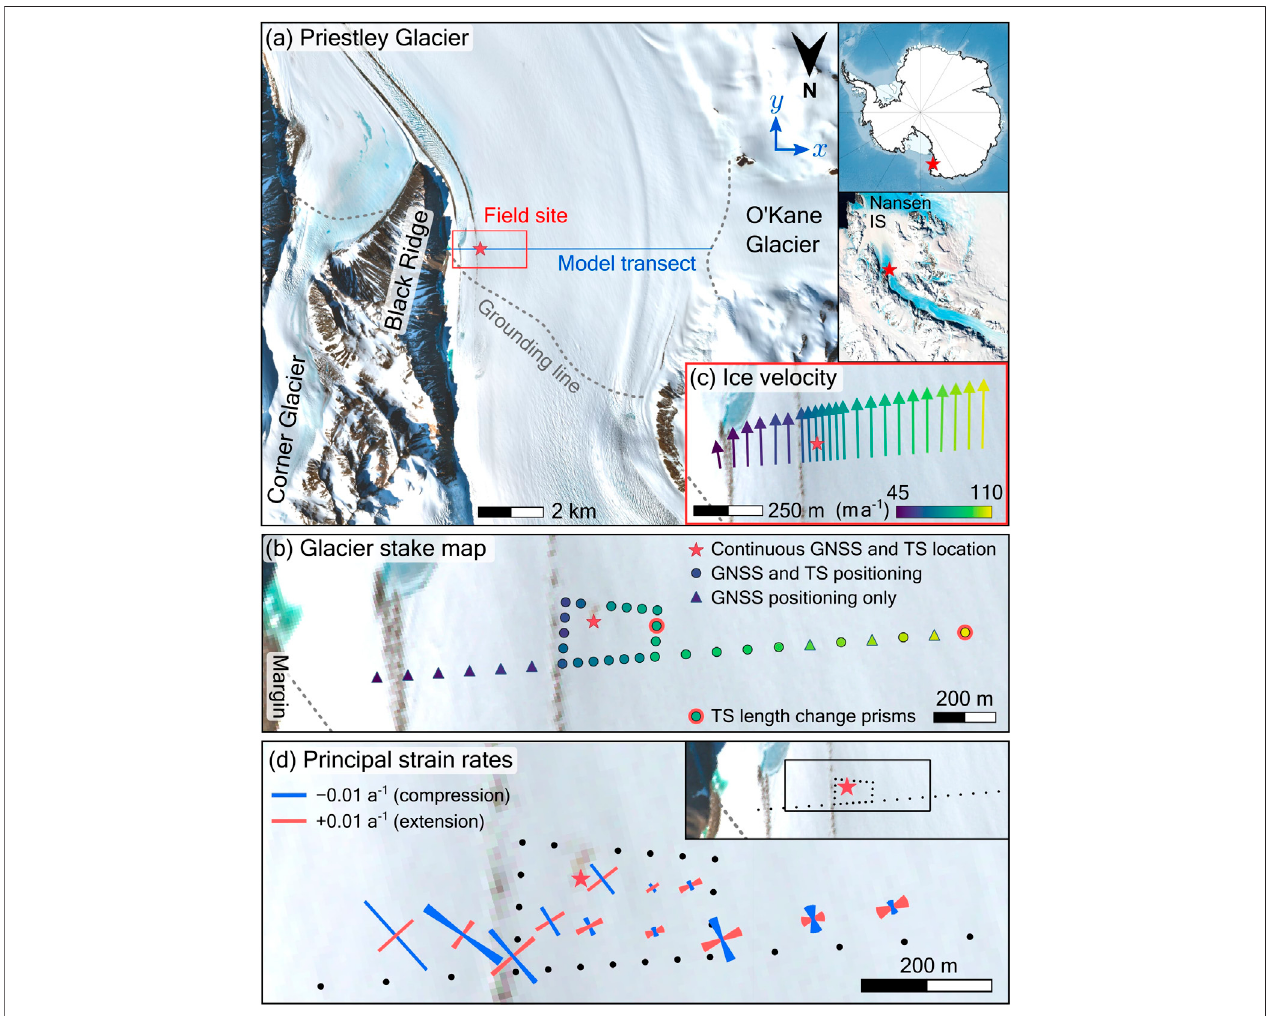
FIGURE 1| (A) Priestley Glacier ’ s left lateral shear margin and two nearby tributary glaciers (O ’ Kane and Corner Glaciers). The red star indicates the location of the GNSSreceiverandtotalstation(TS)installedtomonitortidally-forcedvariationsiniceposition.ThebasemapisaSentinel-2,10 mtruecolourcompositeimage,courtesy oftheEuropean SpaceAgency.Theapproximategrounding linelocation(dashedline)isfrom Rignotet al.(2016) andtheinsetmapisfrom theLandsatImage Mosaicof Antarctica (LIMA) (Bindschadler et al., 2008). (B) The locations of stakes installed across the shear margin. (C) The ice velocity gradient inferred with GNSS positioning. (D) Principal strain rates near the GNSS station and shallow ice coring site, computed from GNSS-observed ice velocities. The blue line denotes the maximum compressional strain rate and the red line denotes the maximum extensional strain rate. The error on the direction is 2 σ .